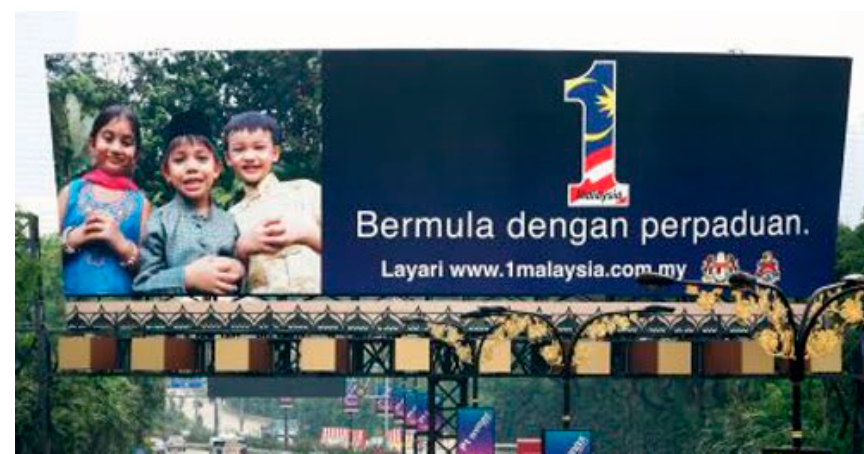
Figure 5. A living interaction between children of different groups.